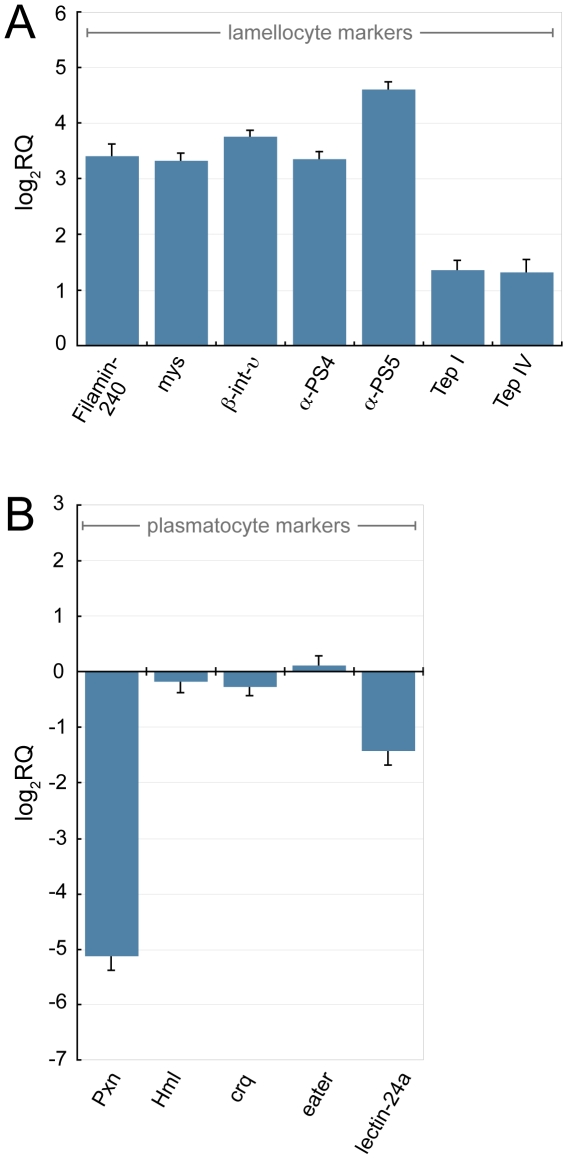
Chn over-expression activates transcription of lamellocyte markers and represses transcription of plasmatocyte markers.
Pxn-GAL4, UAS-GFP; Ubi-GAL80ts x UAS-chn larvae were raised at 18°C (GAL4 repressed) and Chn was induced by up-shift to 29°C for 24 hours. Pxn-GAL4, UAS-GFP; Ubi-GAL80ts x UAS-chn larvae raised entirely at 18°C provided an uninduced control. mRNA was isolated from hemocytes from wandering stage third instar larvae and relative transcript abundance in Chn expressing relative to uninduced control hemocytes was determined by real-time PCR. RpL32 provided an endogenous control to normalize expression. Relative transcript abundance after Chn over-expression of (A) lamellocyte markers and (B) plasmatocyte markers. Data are mean and standard deviation of three independent determinations.